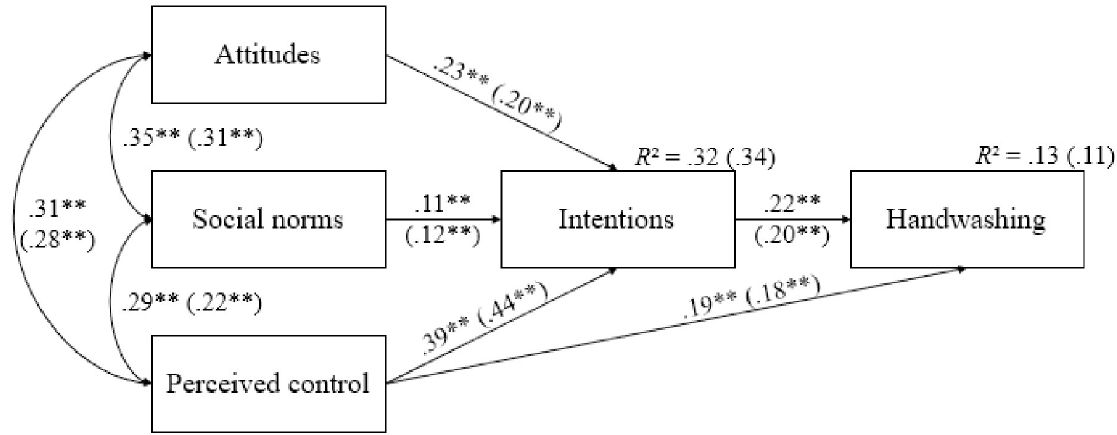
Fig 4. Standardized path coefficients for Belgian and French (in parentheses) residents for handwashing ( N = 3744). �� p < .001. R 2 = R-squared.